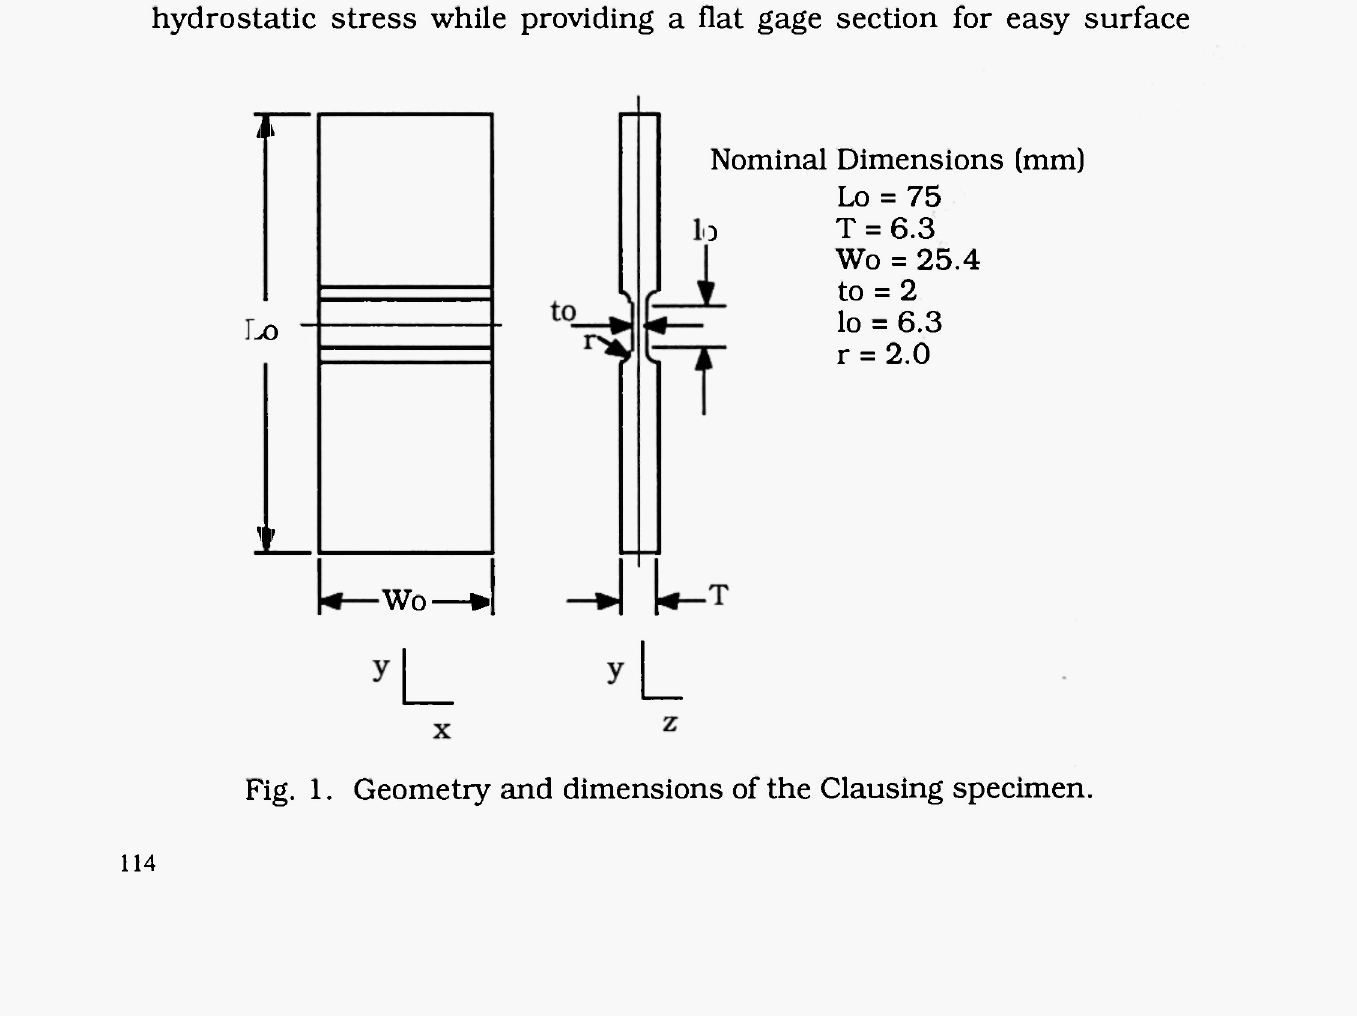
Fig. 1. Geometry and dimensions of the Clausing